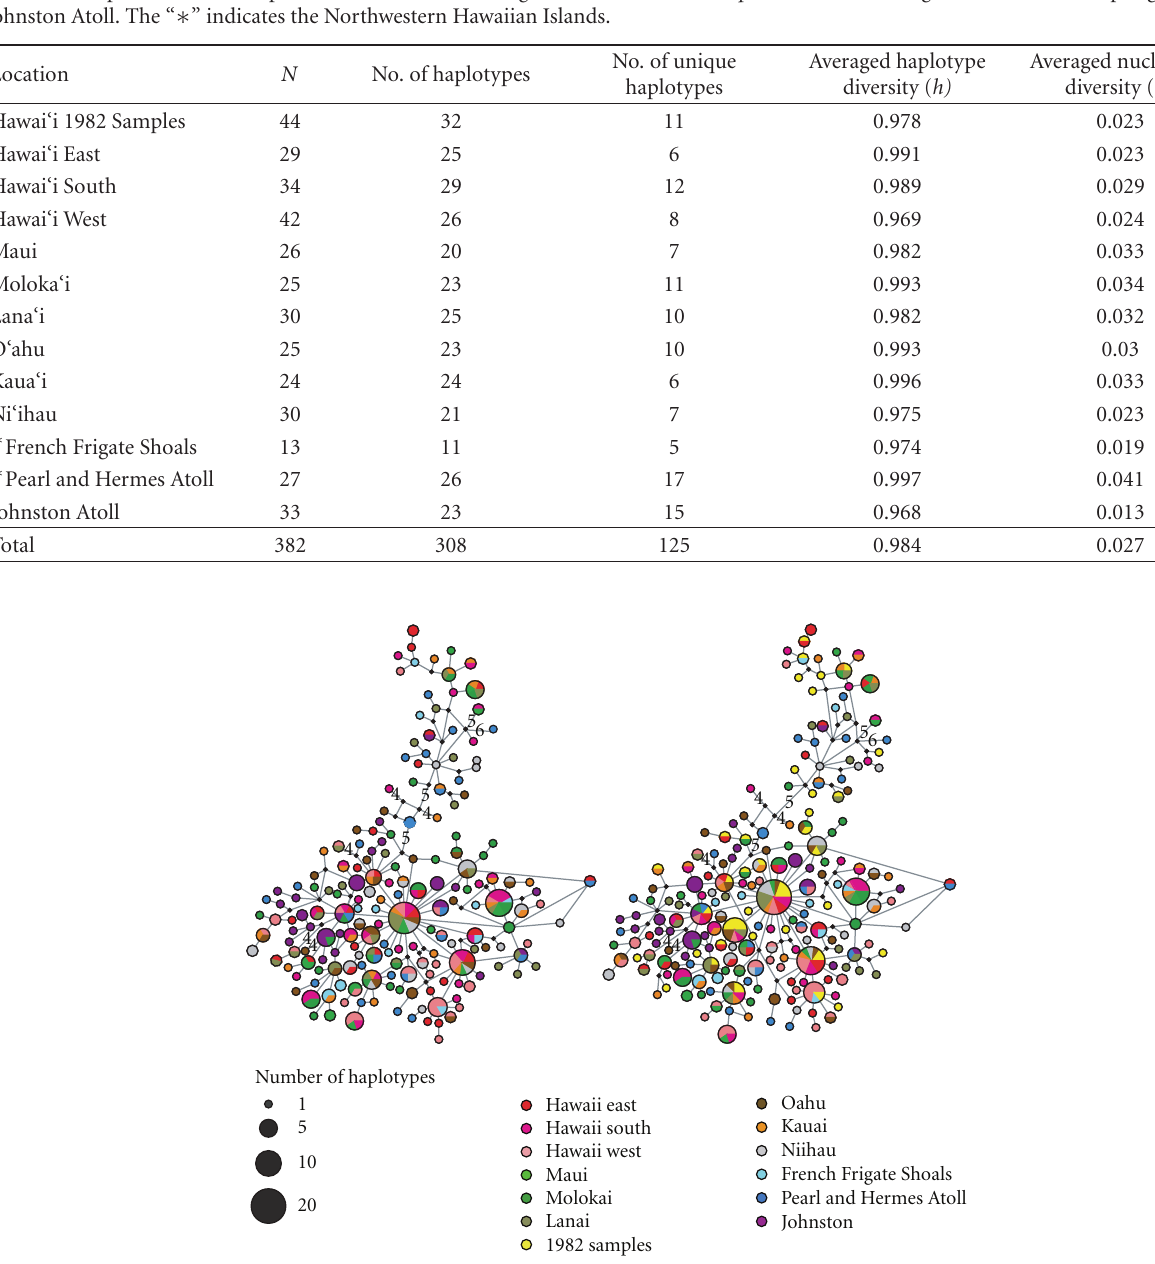
Table 1: Sample size and descriptive statistics for control region data of Acanthaster planci collected along the Hawaiian Archipelago and at Johnston Atoll. The “ ∗ ” indicates the Northwestern Hawaiian Islands.